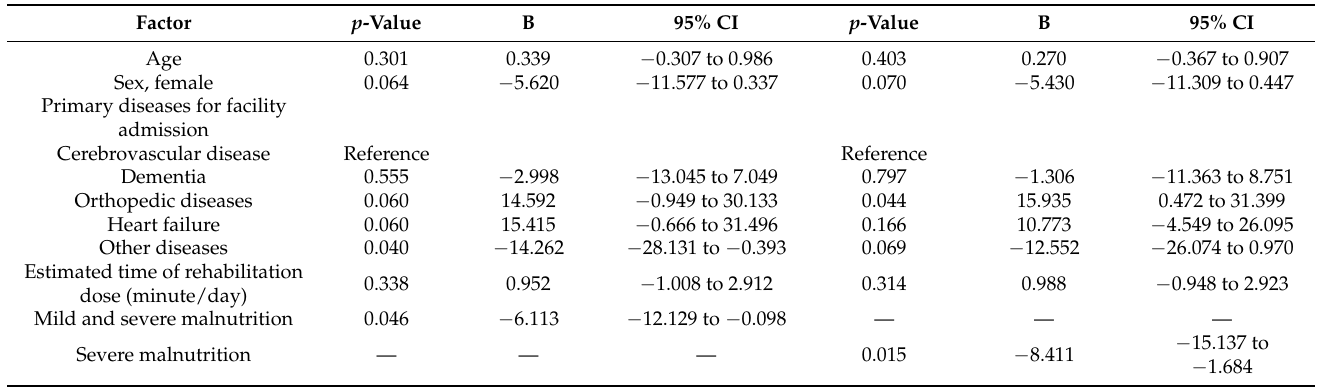
Table 4. Multiple linear regression analysis of the Barthel